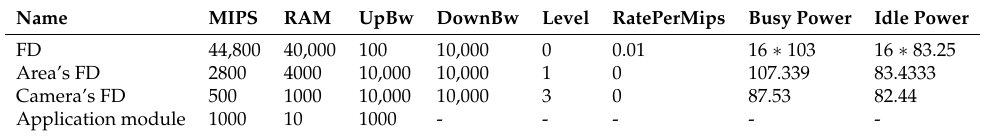
Table 3. Simulation configuration.